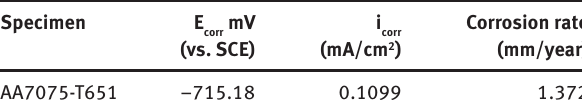
Table 3: Potentiodynamic polarisation test summary. Specimen